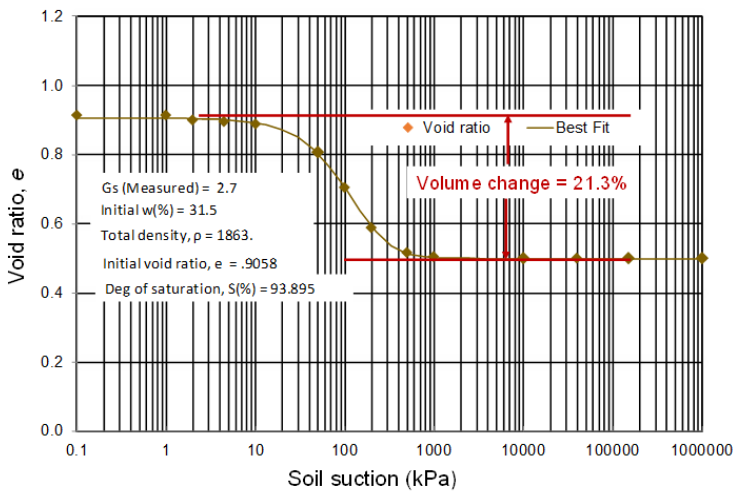
Figure 14. Graphical presentation of the best-fit soil suction characteristic curve ( e -CC) data and the calculated curve from the regression analysis parameters.